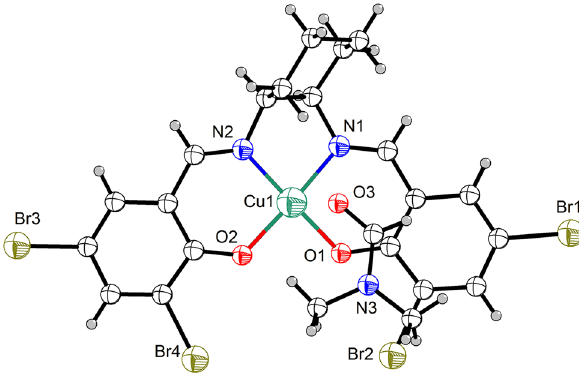
Table  : Data collection and handling. Crystal: Block, clear blackish black